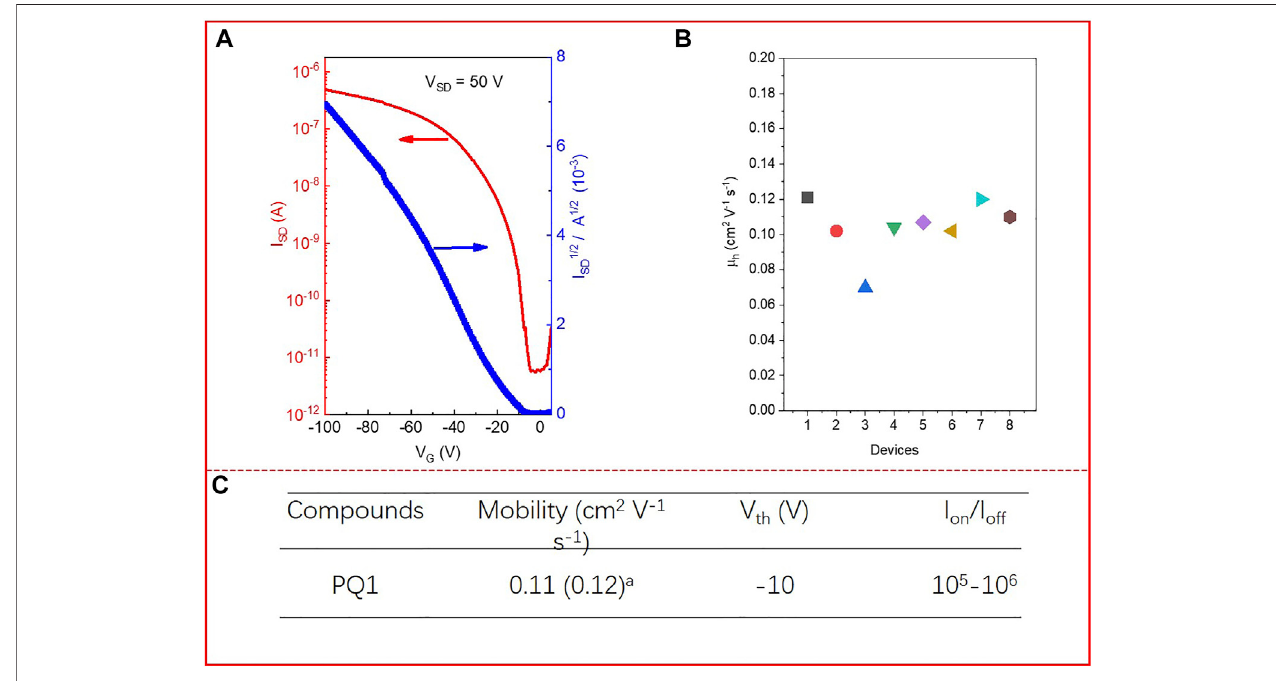
FIGURE 2 | (A) Characteristics of the OFET devices of PQ1; (B) hole transport mobility obtained eight different devices. (C) Hole mobilities (µ h ), threshold voltage (V Th ), and on/off ratios (I on /I off ) of the PQ1-based FET device. The mobility was provided in average (highest) a form and the performance is based on eight different FETs. Mobility extracted by fi tting the linear part of the plot of I DS1/2 versus V G using the equation I DS = C i µ(V G -V Th ) 2 W/2L. a Hole